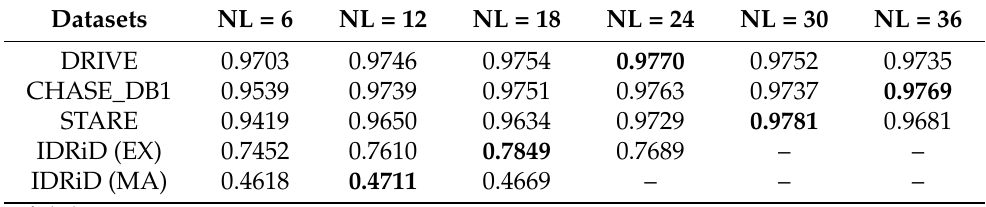
Table 13. Segmentation results when varying the network depth (NL denotes the number of convolu- tional layers in the backbone of the LightEyes, and we use AUC/F1-score to evaluate vessel/lesion segmentation maps). Best results are